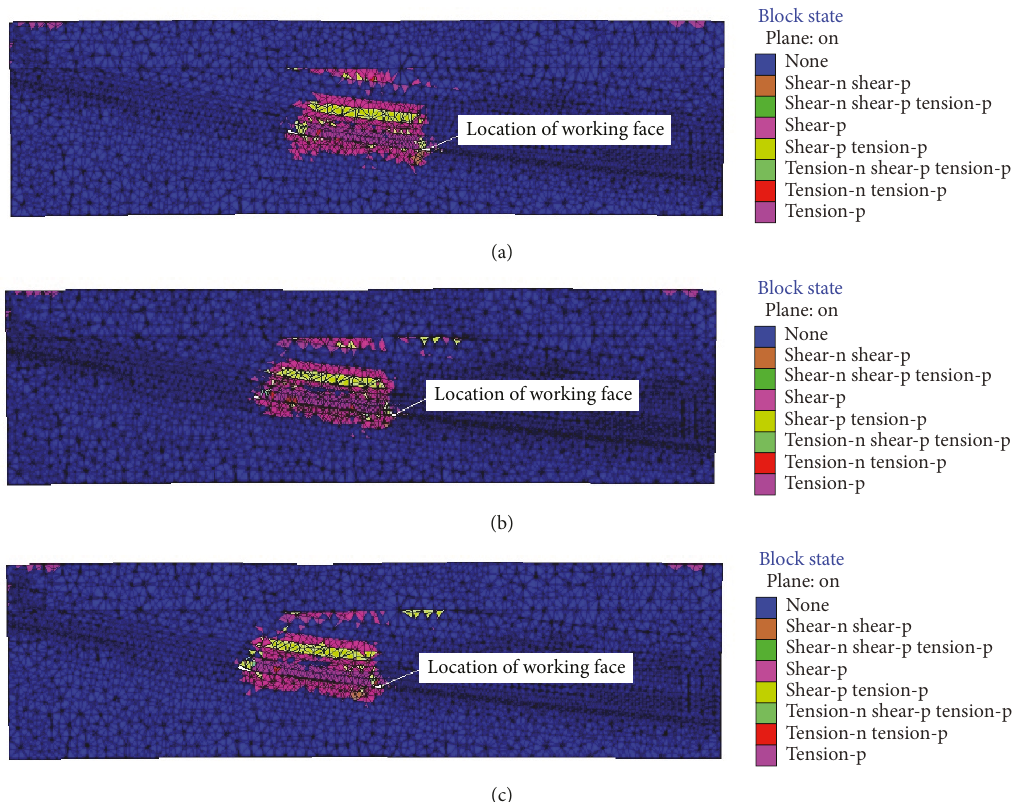
Figure 6: Distribution of plastic deformation in overlying strata at di ff erent mining upper limits: (a) mined upper limit of -715 m, (b) mined upper limit of -710 m, and (c) mined upper limit of -705